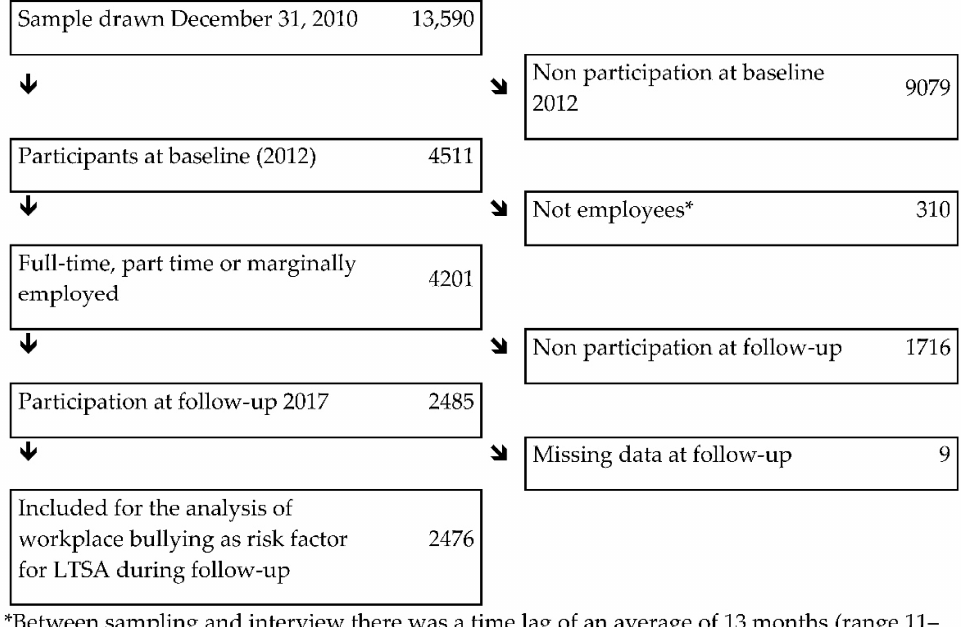
Figure 1. Flow diagram of participation in SMGA’s 2012 baseline and the 2012–2017